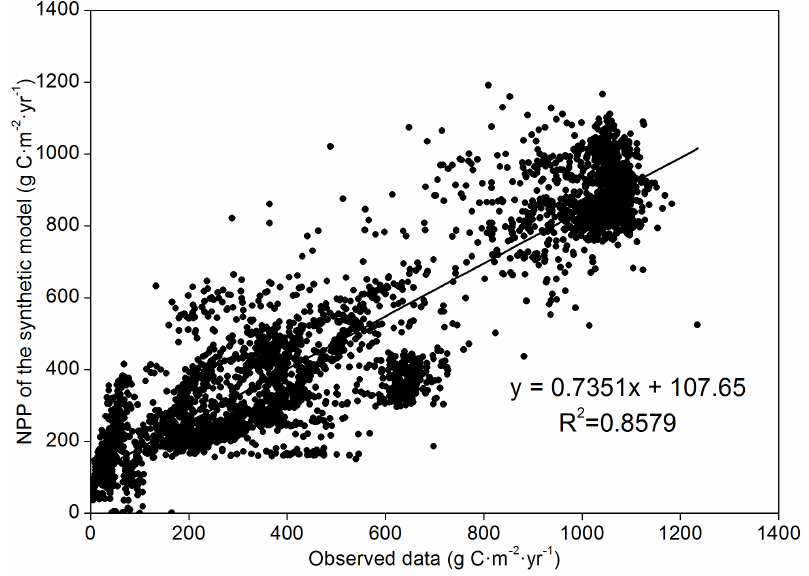
Figure 4. Comparison of NPP value simulated by synthetic model and observed data ( r=0.9262,P , 0.001 ). The observed data are collected from the Oak Ridge National Laboratory (ORNL). These data, and further information about the study sites, are publicly available at www. daac.ornl.gov/NPP/.